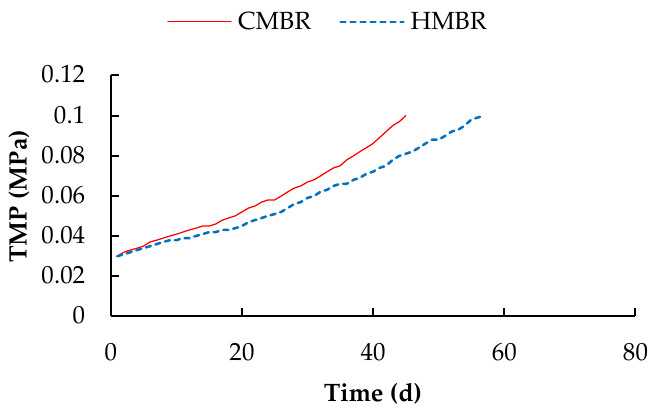
Figure 2. Transmembrane pressure (TMP) Variation in conventional membrane bioreactor (CMBR) and hybrid membrane bioreactor (HMBR).